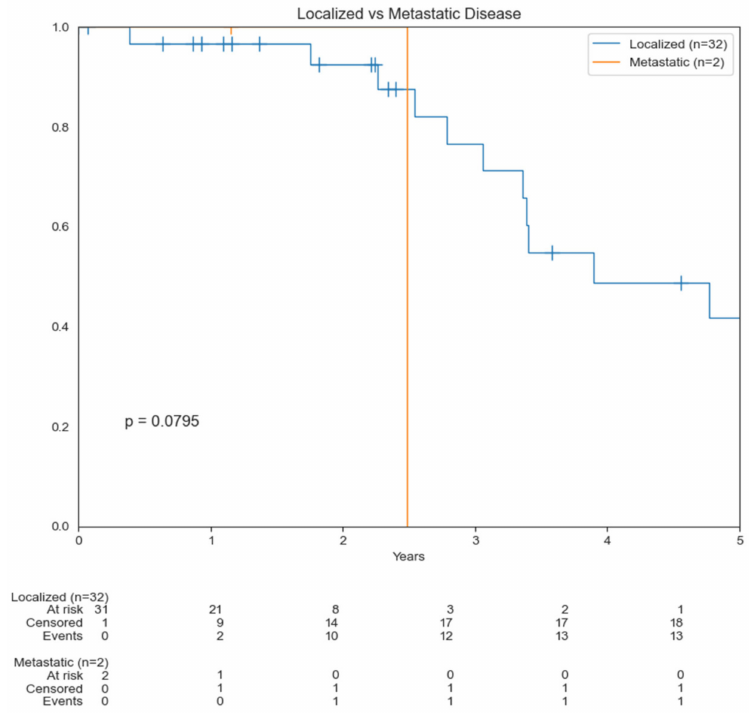
Figure 1. Kaplan–Meier curves comparing overall survival (OS) based on localized disease versus metastasis. Table 2. Summary of treatment